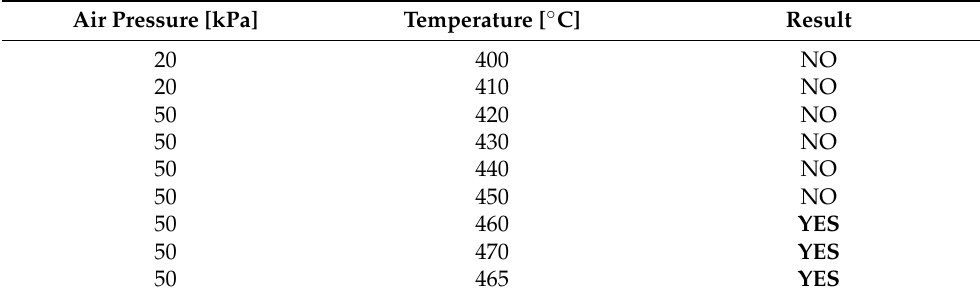
Table 2. Measured values of MIT (sample weight 0.15 g).